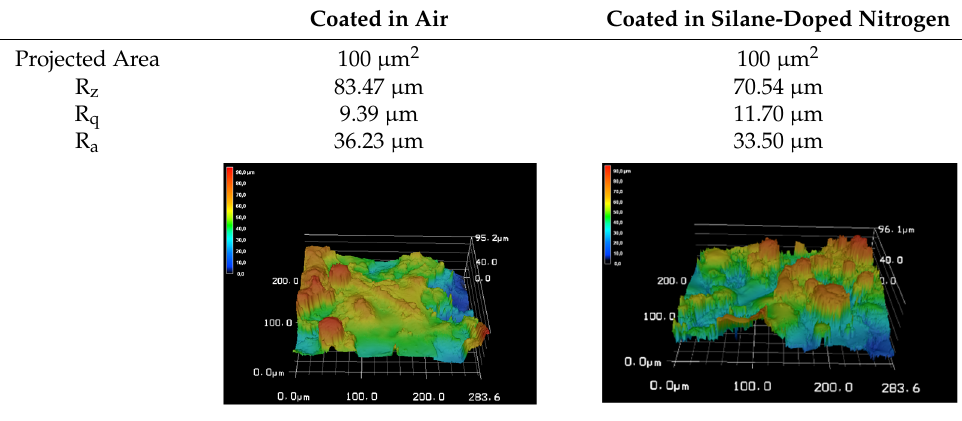
produced in an oxygen-free environment; ( c ) coating surface of a conventional copper coating.